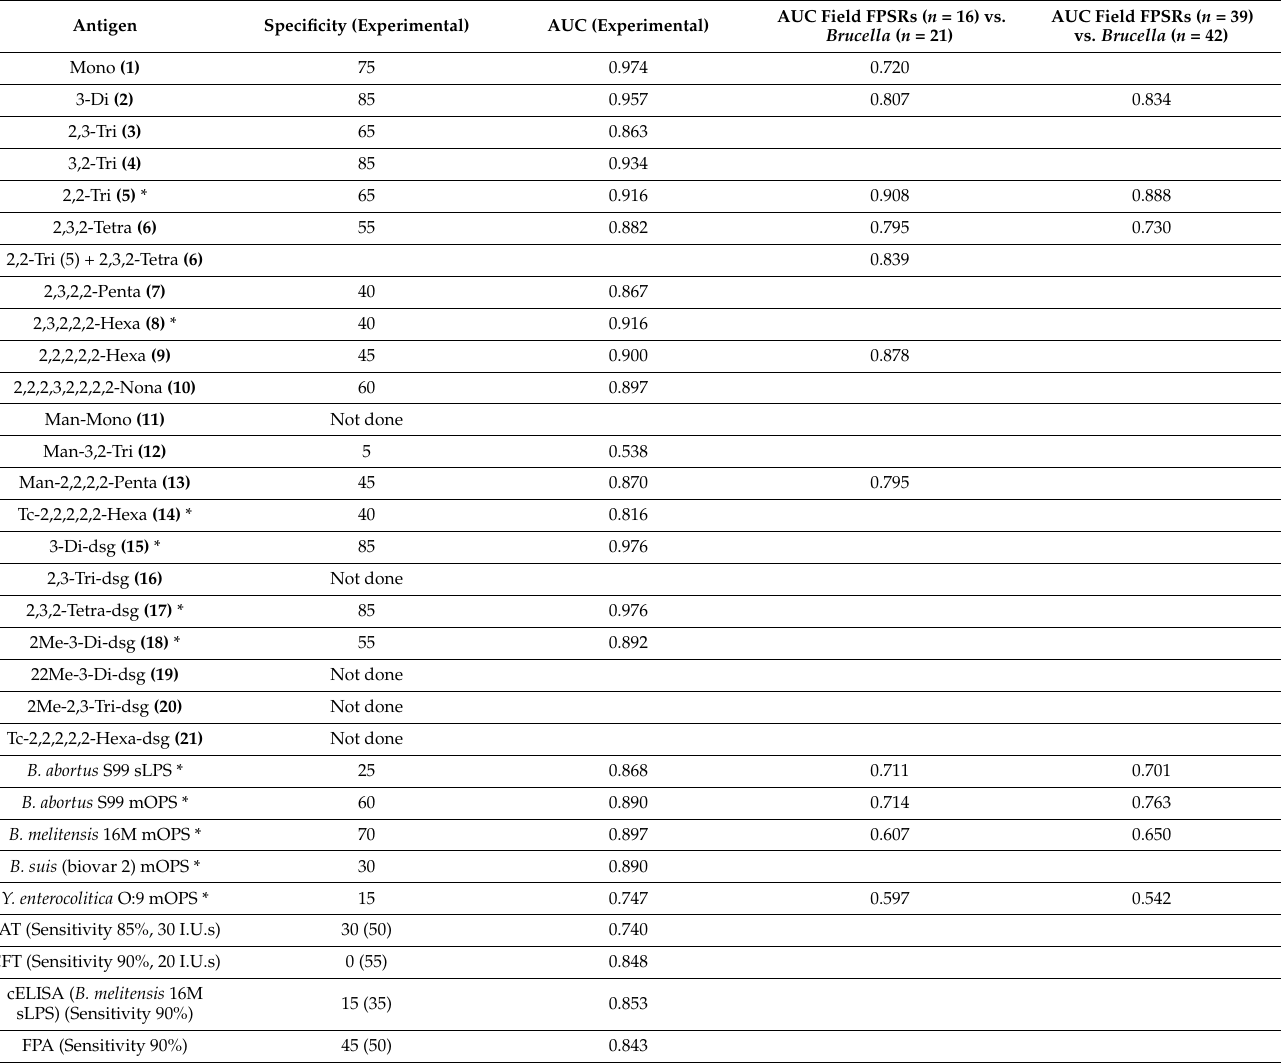
Table 2. AUC and DSp for samples from experimentally infected cattle and for field